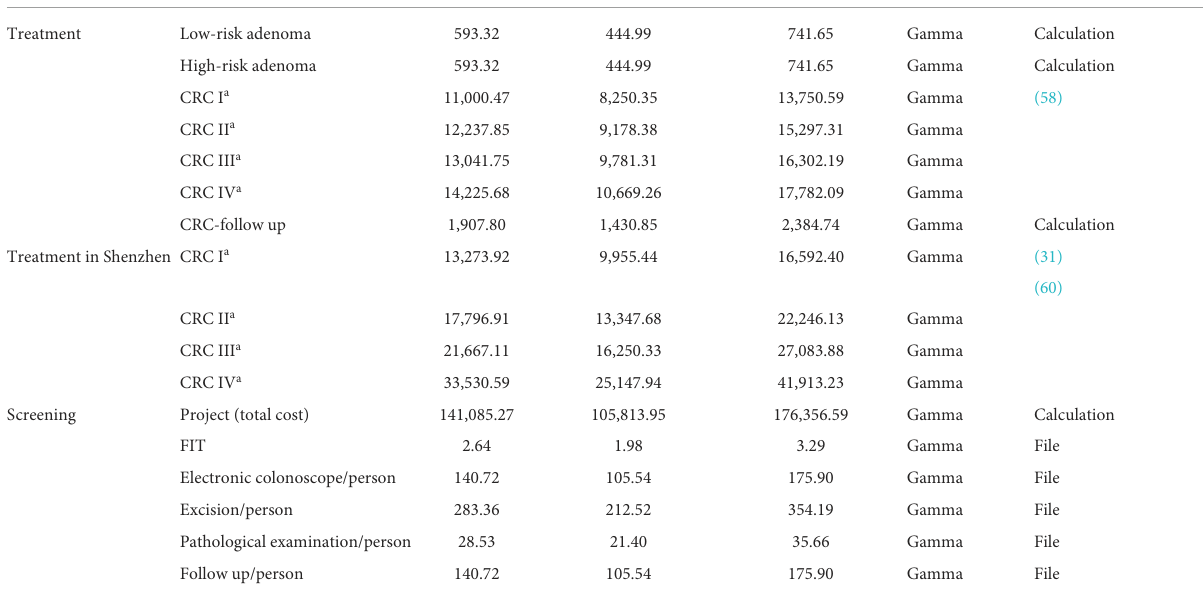
TABLE 2 Cost parameters.